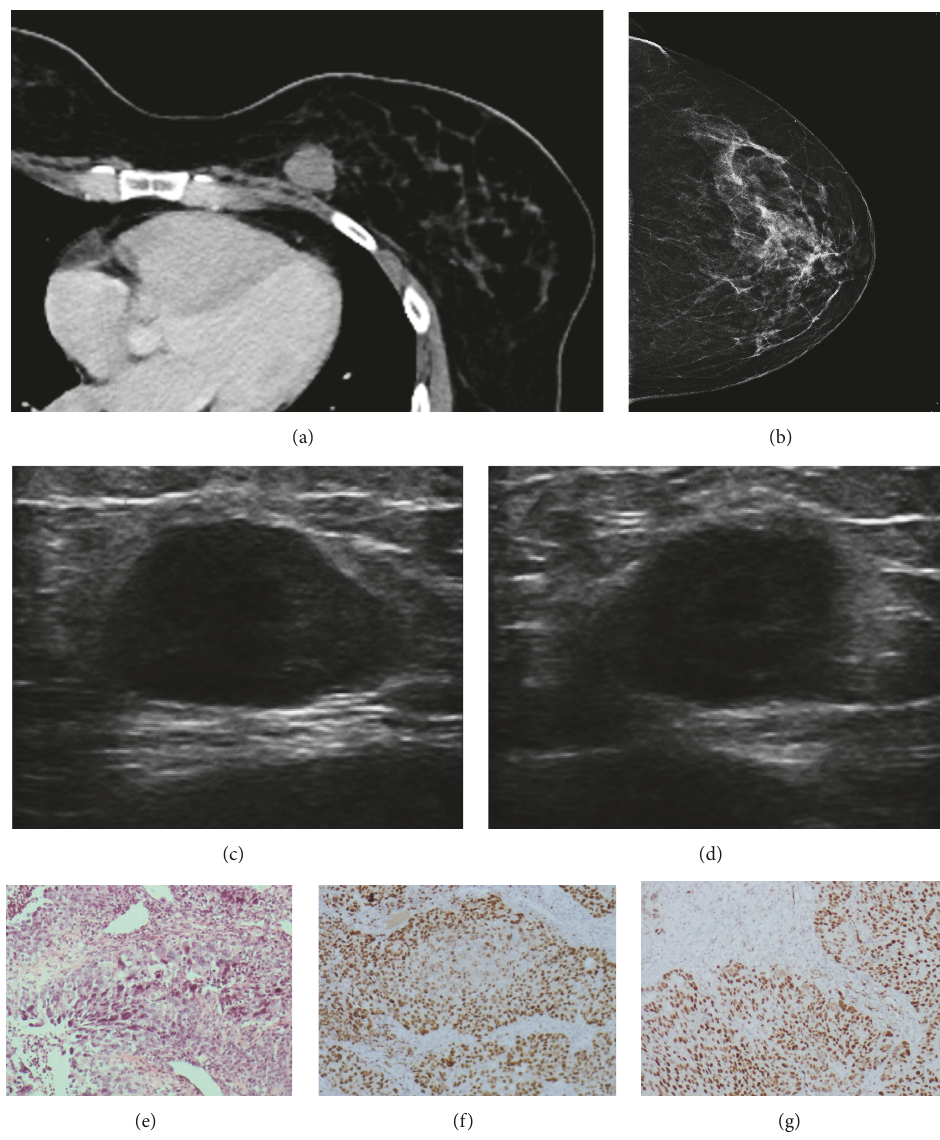
Figure 3: Case3. A 41-year-old woman diagnosed with a low-differentiated carcinoma.Contrast-enhancedcomputed tomography (CT) scan demonstrated an incidental finding consistent with a mass on the right breast ( a ). Although this lesion was palpable, it was not detectable on mammography ( b ). Then, an ultrasound was performed, showing an oval mass with parallel orientation, indistinct margins, a heterogeneous echo pattern, and posterior acoustic enhancement ( c–d ). HE staining and immunohistochemistry analysis of the metastases. HE staining revealed the malignant cells in the breast tumor ( e ), and the immunohistochemistry analysis indicated that the cells were positive for PAX8 ( f ) and WT4 ( g